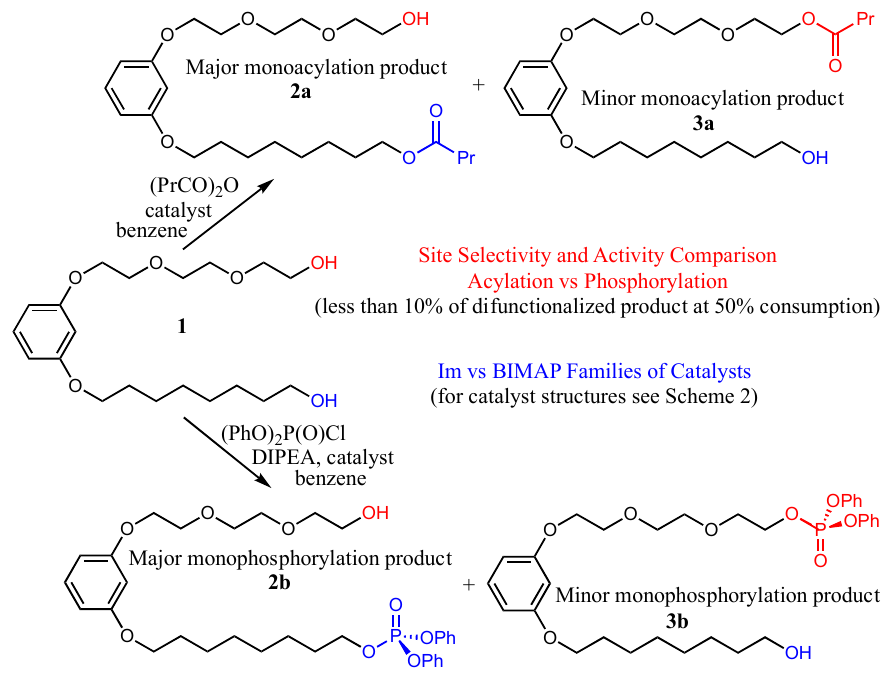
Scheme 3. The site selectivity and activity comparison with model diol substrate 1 .